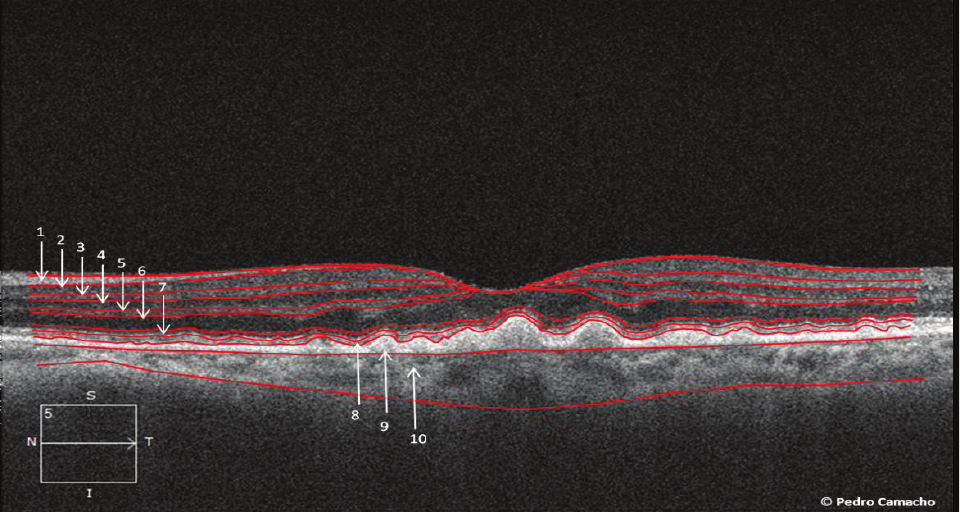
Figure 1. 1, (RNFL) retinal nerve fiber layer; 2, (GCL) ganglion cell layer; 3, (IPL) inner plexiform layer; 2+3, (GCL+IPL) ganglion cell layer with inner plexiform layer ; 4, (INL) inner nuclear layer; 5, (OPL) outer plexiform layer; 6, (ONL) outer nuclear layer; 5+6, (OPL+ONL) outer plexiform layer with outer nuclear layer 7, (MZ) myoid zone of the photoreceptors; 8, (OS) outer segments of photoreceptors; 9, RPE+BM complex (interdigitation between apical processes of the RPE and external portion of the external segments of the photoreceptors and Bruch membrane); 10, choroid thickness.